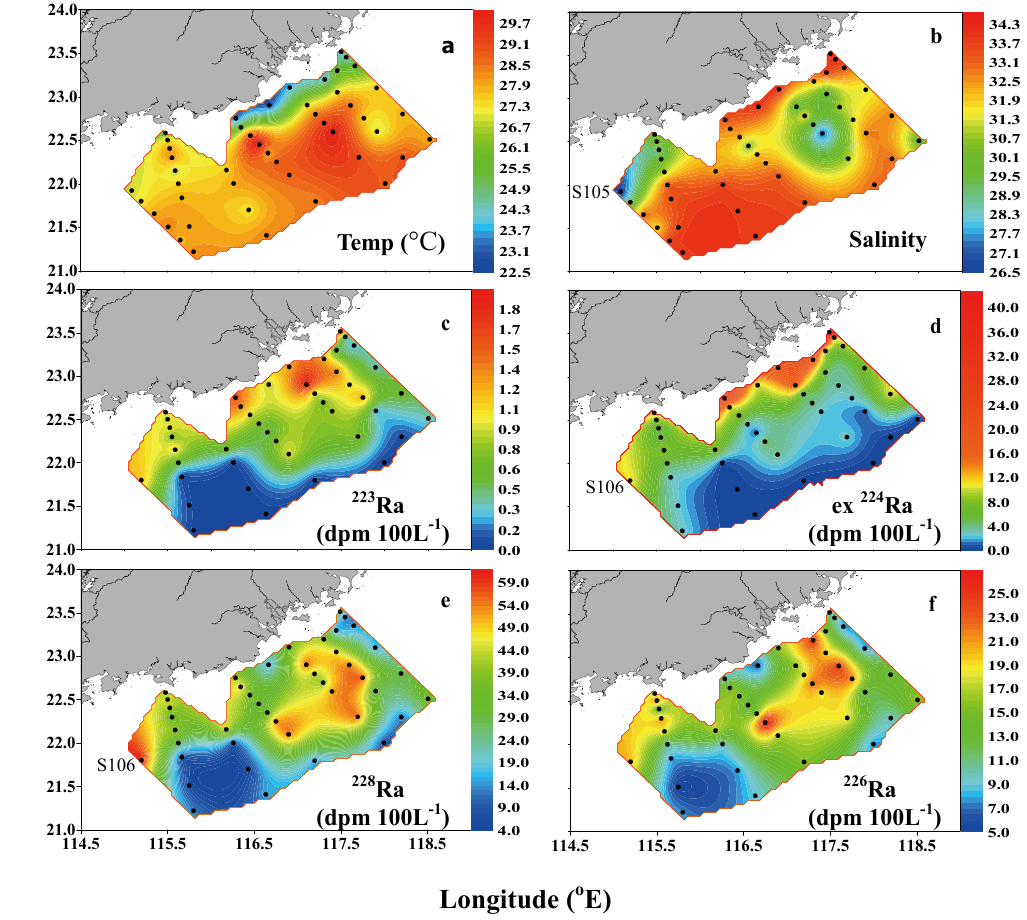
Fig. 2. Contour maps showing the distributions of (a) temperature ( ◦ C), (b) salinity, (c) 223 Ra (dpm 100L − 1 ) , (d) ex 224 Ra (excess 224 Ra, corrected for the ingrowth from 228 Th; dpm 100L − 1 ) , (e) 228 Ra (dpm 100L − 1 ) , and (f) 226 Ra (dpm 100L − 1 ) on the northern South China Sea shelf during 30 June–8 July, 2008.